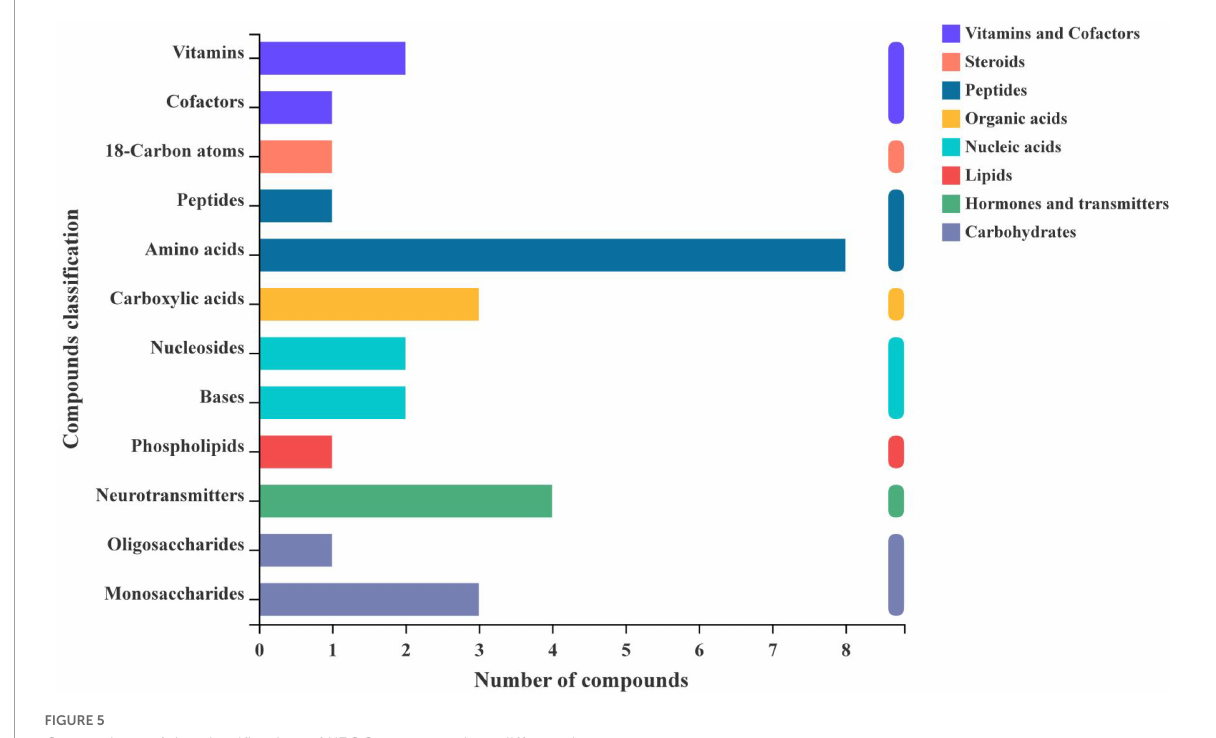
FIGURE5 Comparison of the classification of KEGG compounds at different